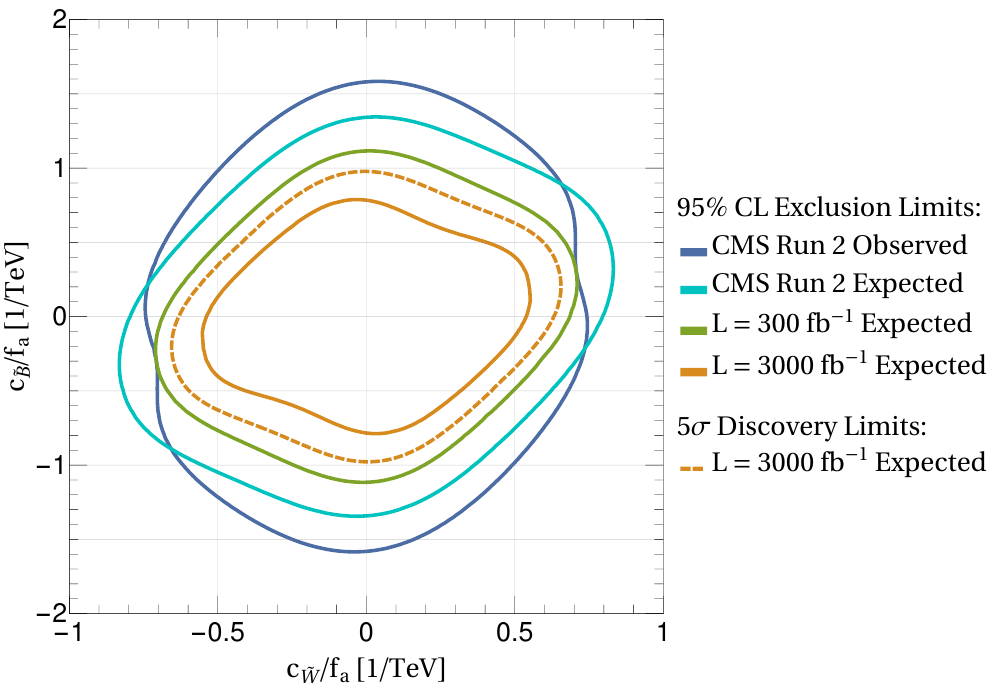
√ /f a , c /f a ) for s = 14 TeV , e W e B